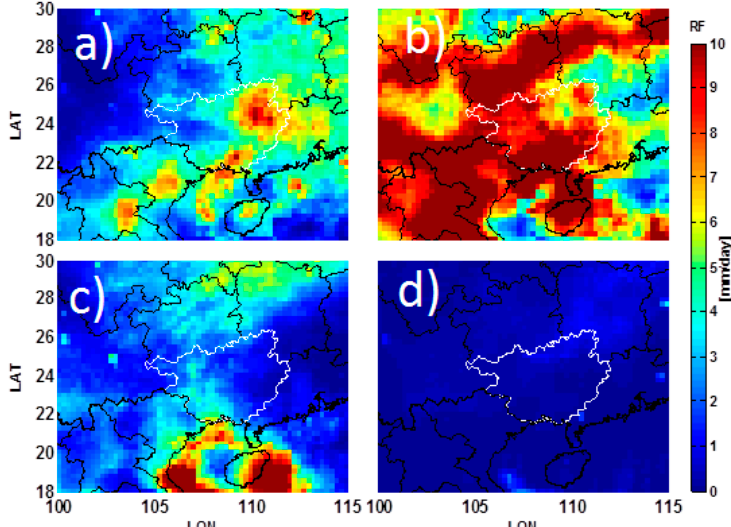
Figure 10. Rainfall distribution in 2014 based on TRMM ( a ) April; ( b ) July; ( c ) October; ( d ) January.